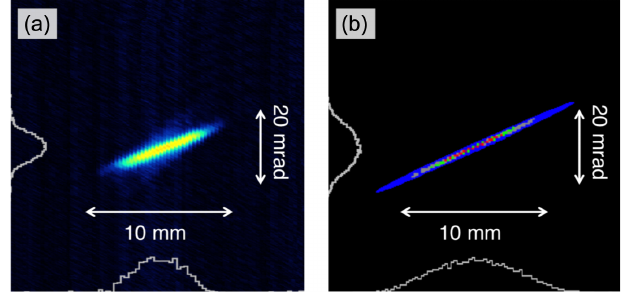
FIG. 12. Phase-space profile of the 500 keV, 1 nC beam. (a) Measured and (b) simulated phase-space profiles after the rf electron gun system using CST and PARMELA codes. The hori- zontal and vertical scales are the same in the two figures.